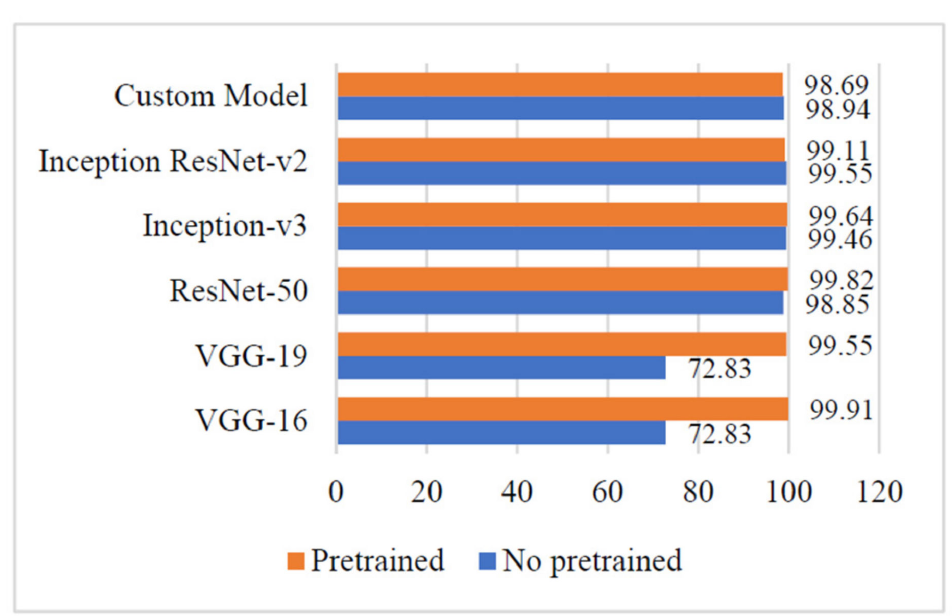
Figure 10. F1 score of different deep learning